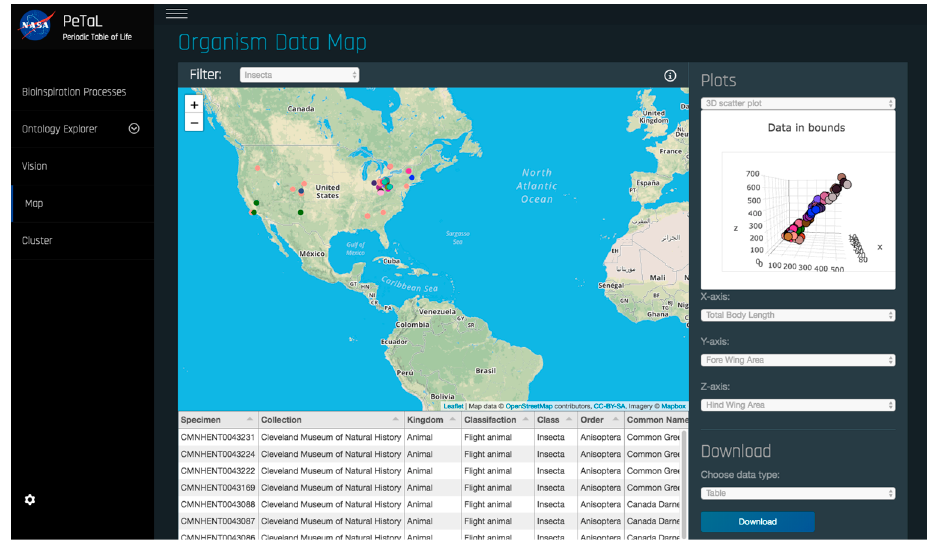
Figure 34. Map explorer that shows geographical distribution of species in the database. A scatter plot can show statistical relationships between morphology, function and environment or various morphological features.